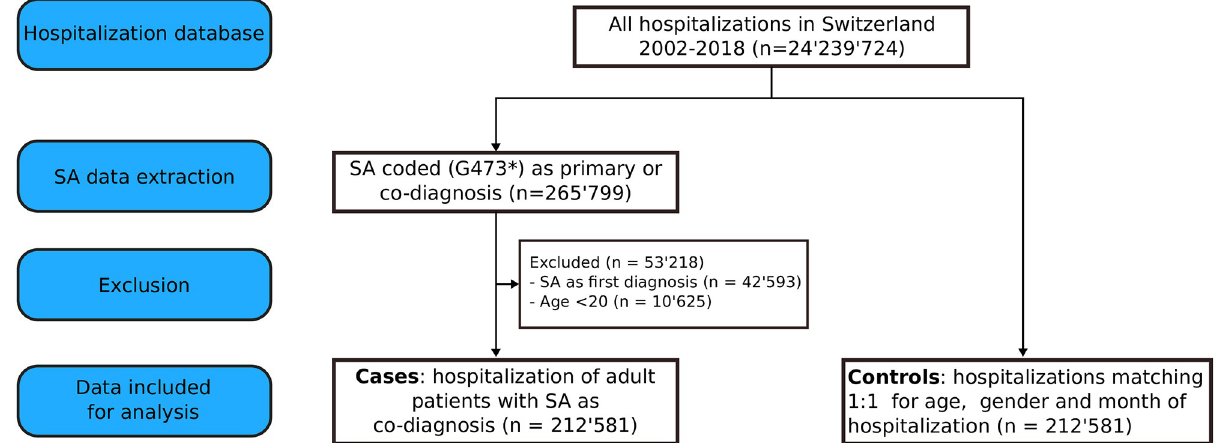
Fig 1. Flow diagram of the study protocol. The study follows a nested case-control design. The cases correspond to the hospitalizations of adults patients with a SA co-diagnosis. The controls correspond to hospitalizations without coded SA in patients matching the cases 1:1 for age, gender and month of